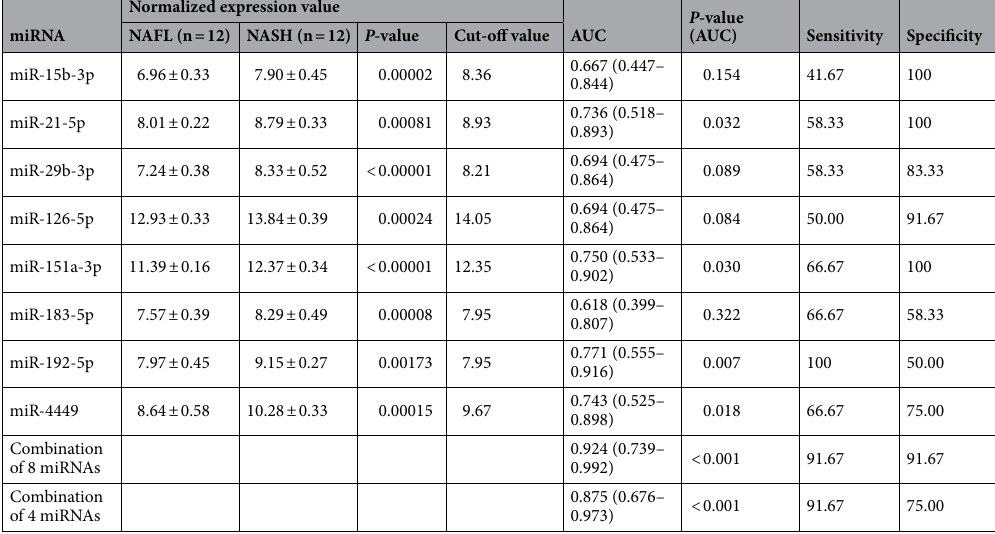
Table 2. Diagnostic accuracy of miRNA for NASH from NGS analysis. NASH nonalcoholic steatohepatitis, NAFL nonalcoholic fatty liver, AUC area under the receiver operating characteristic curve. P -value means that.